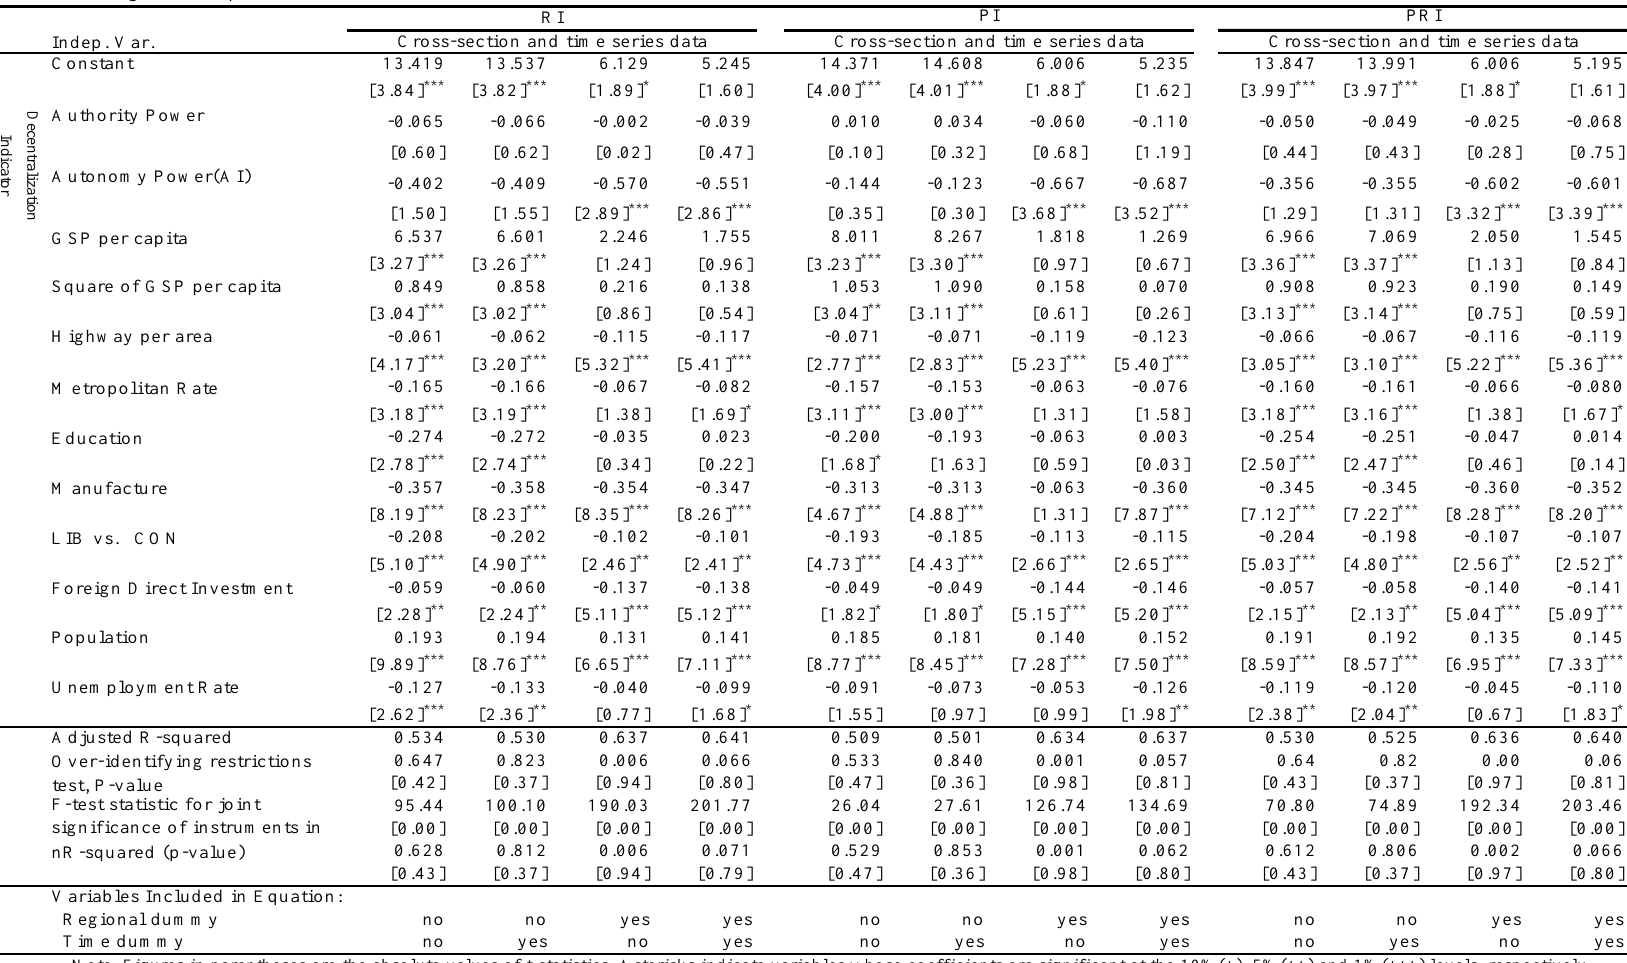
Table 4: Estimation Results (Inequality = CV Coefficient) Method = TSL